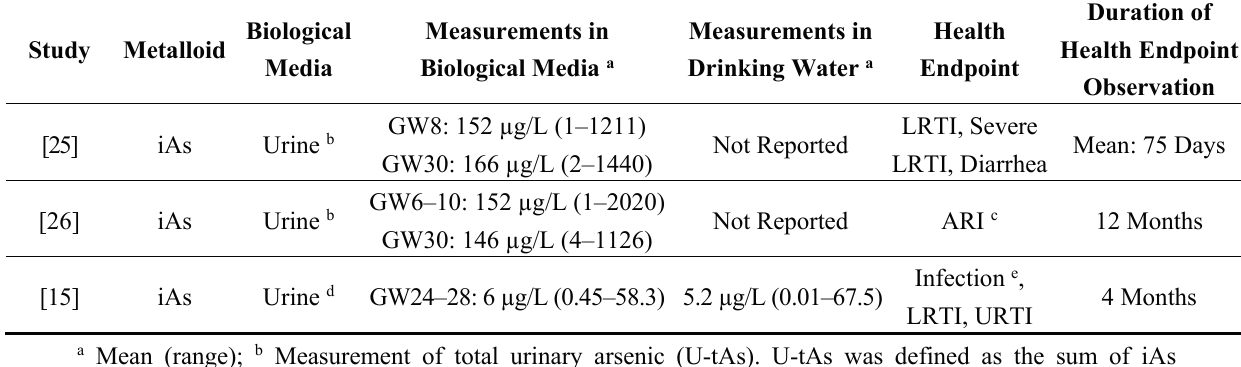
Table 2. iAs levels and health endpoints evaluated in human cohorts providing evidence for increased risk of infectious